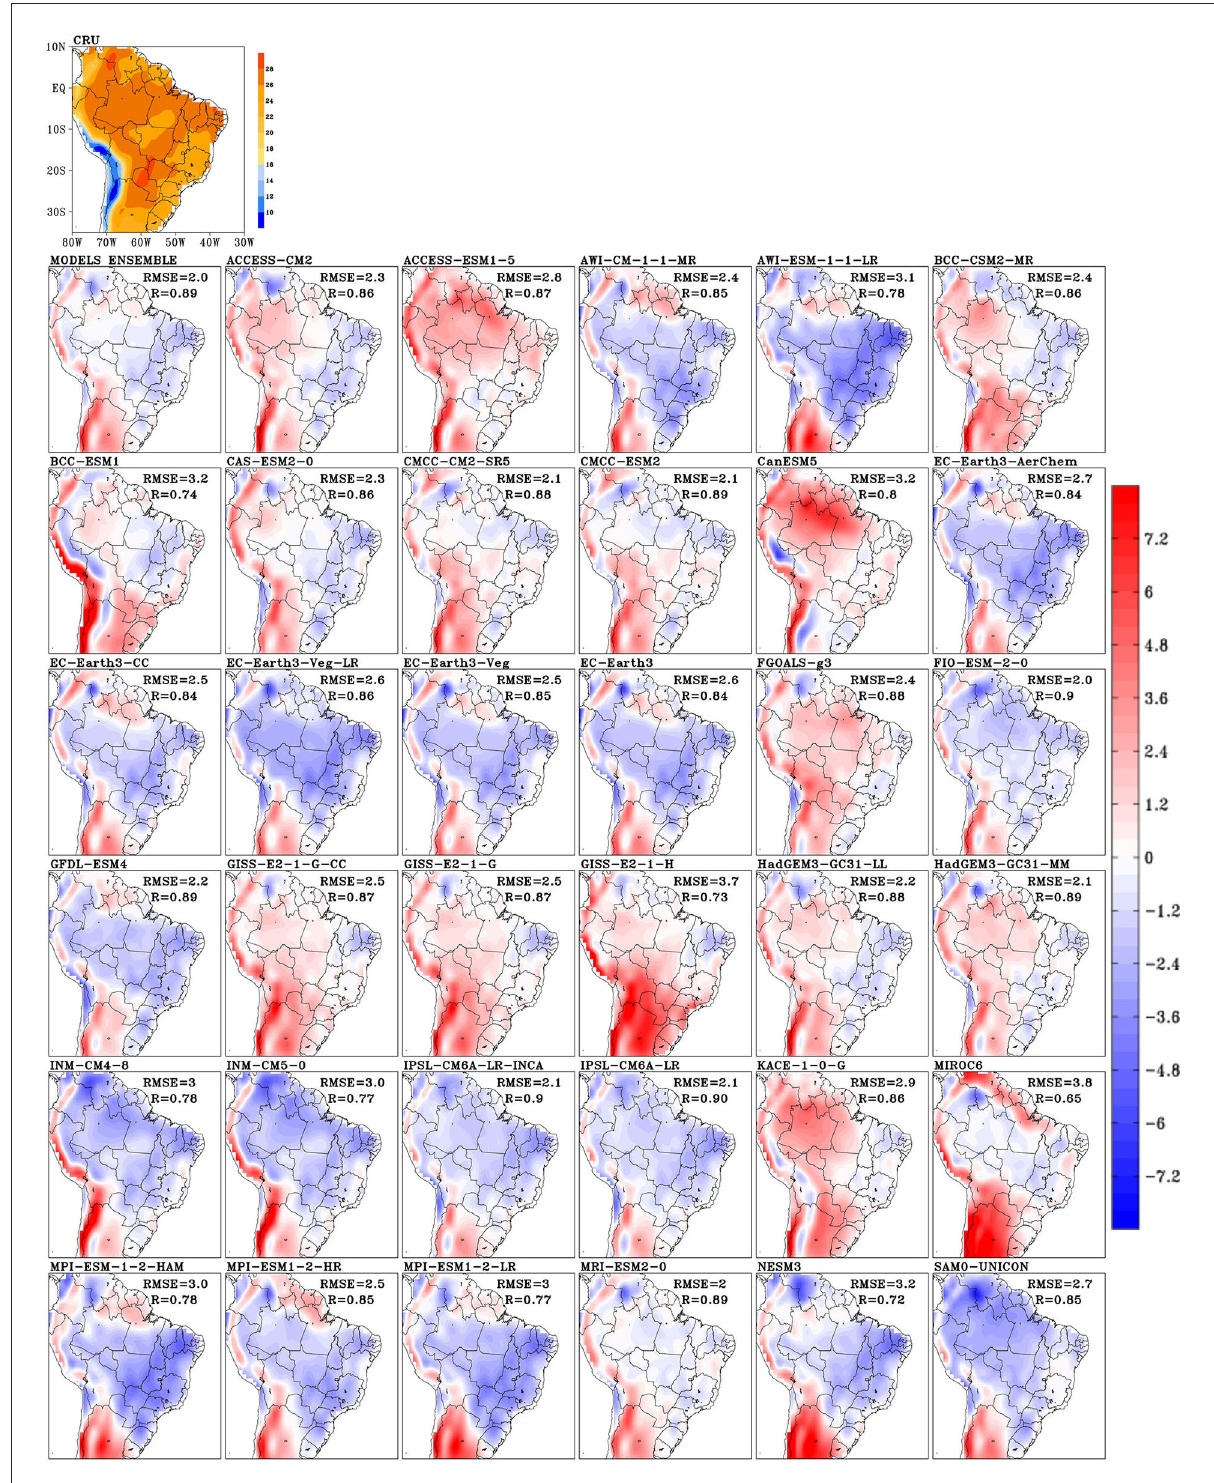
FIGURE8 CMIP6 model biases and CRU-observation (top left panel) for surface air temperature: Austral summer (DJF). Unit: ◦